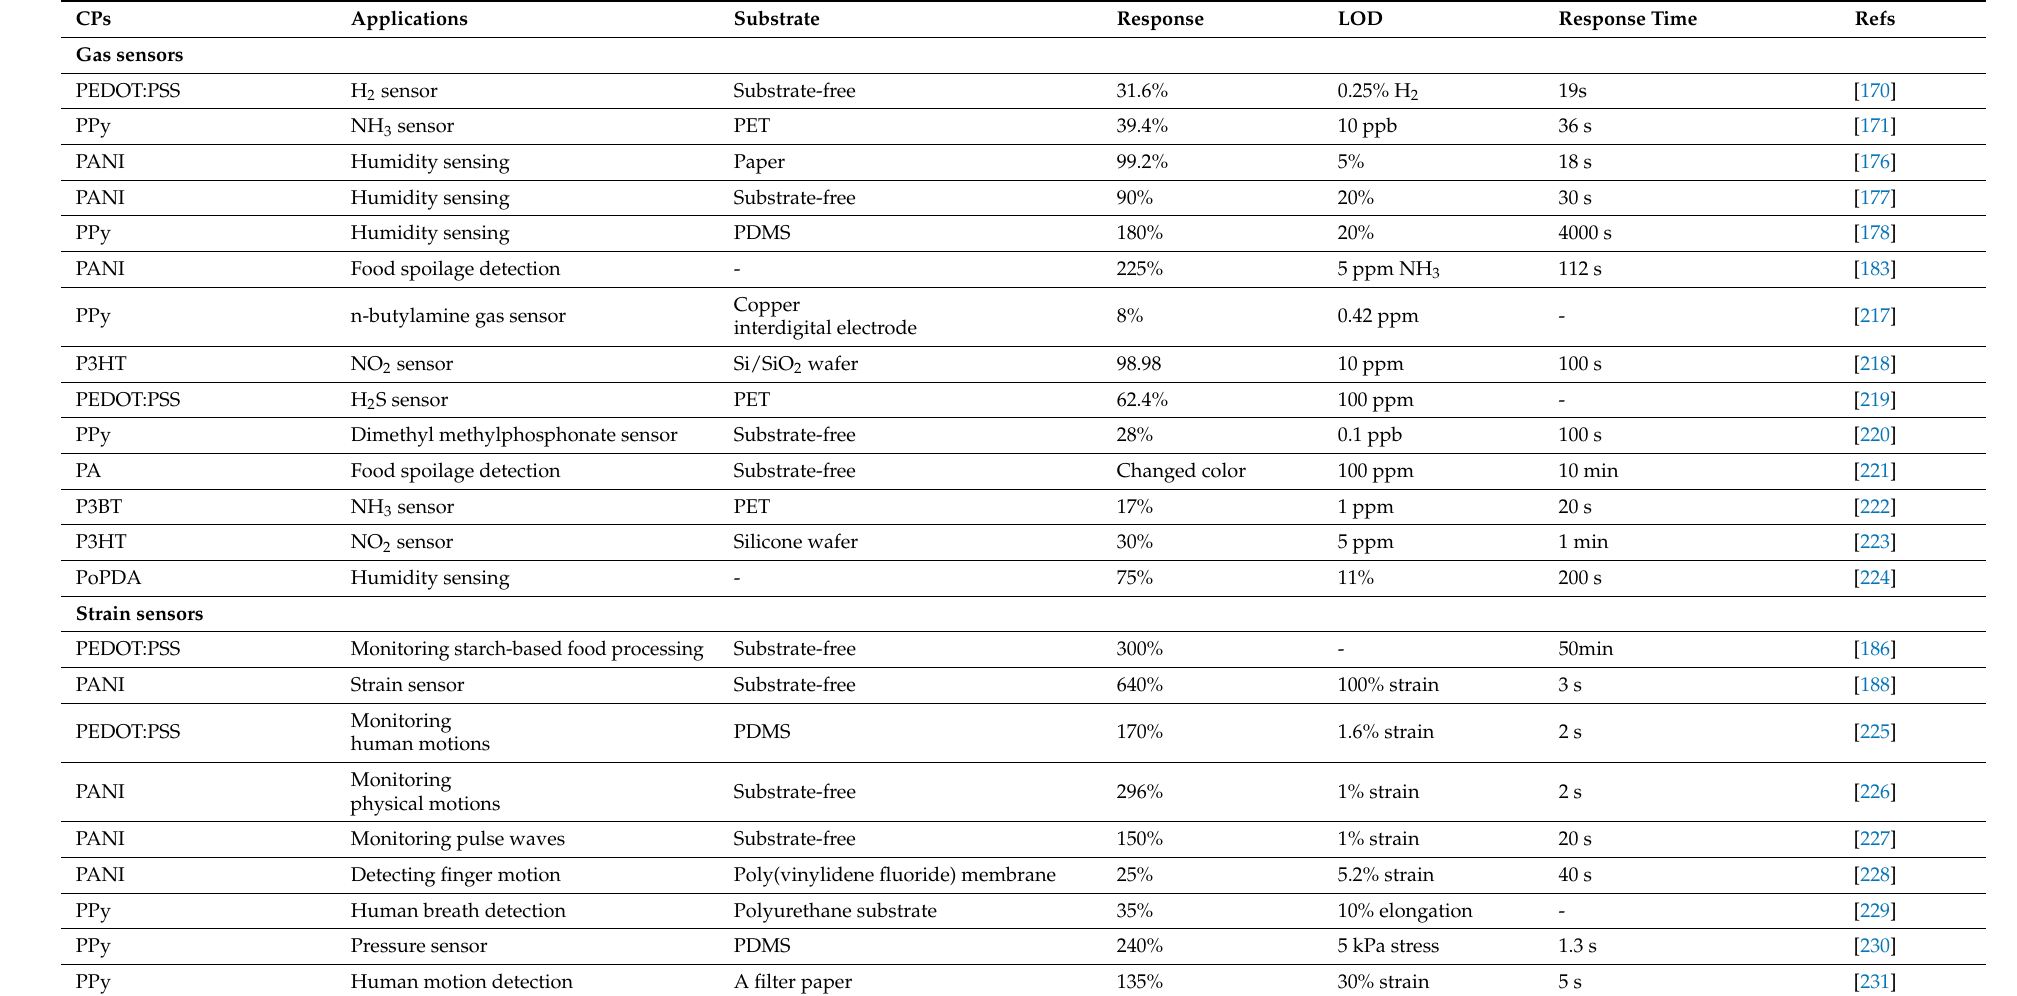
Table 2. Summary of recent applications of conductive polymer-based flexible